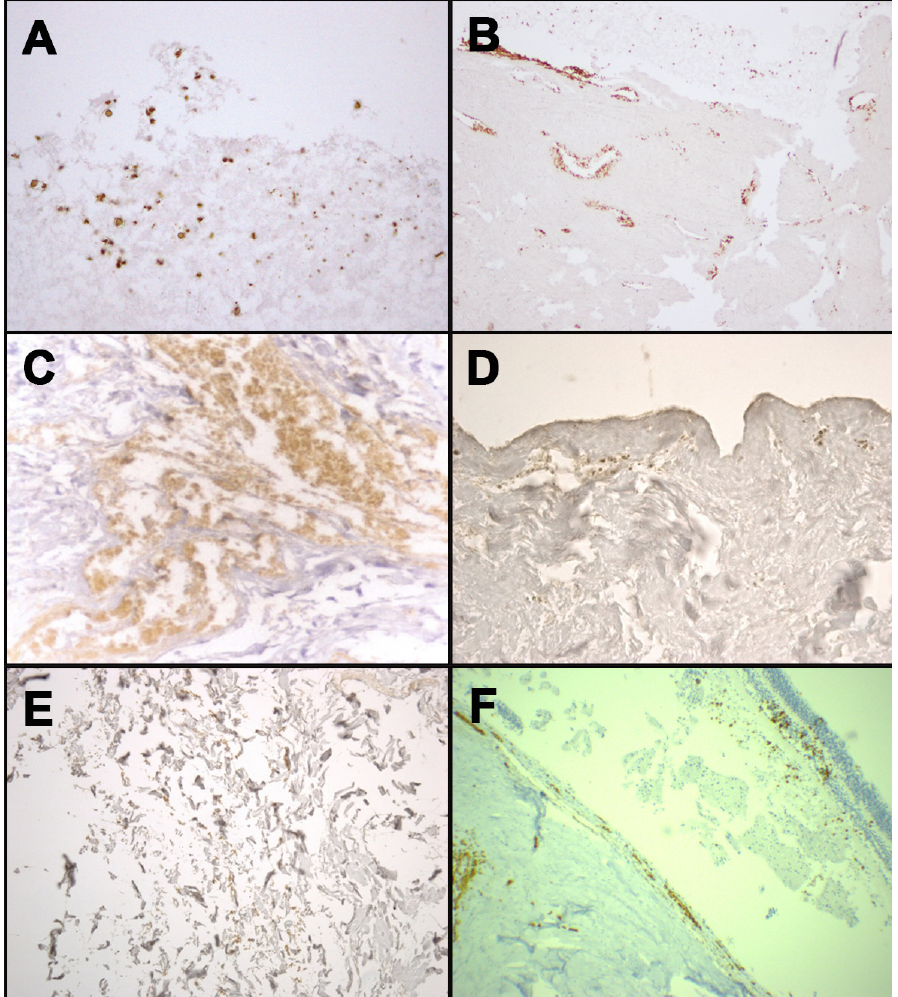
Figure 2. Immunohistochemical staining with anti-human GPA antibody: positivity at the margin of occipital bone fracture from case 1 ( A ); positivity at the stump of the mandible fracture from case 3 ( B ); positivity in the context of soft tissues surrounding laryngeal fracture from case 4 ( C ); positivity in dermis of neck skin from case 5 ( D ); positivity in the contest of soft tissues surrounding rib fracture from case 5 ( E ); positivity of the retinal sample from case 6 ( F ). In case 1, the corpse was found in an advanced stage of decomposition and putre- faction. No radiological evidence of fracture was diagnosed; moreover, no macroscopical hemorrhagic infiltration was observed at pericranial soft tissue examination. However, not significant. Therefore, no evidence allows establishing if the fracture was caused by ante-mortem or post-mortem